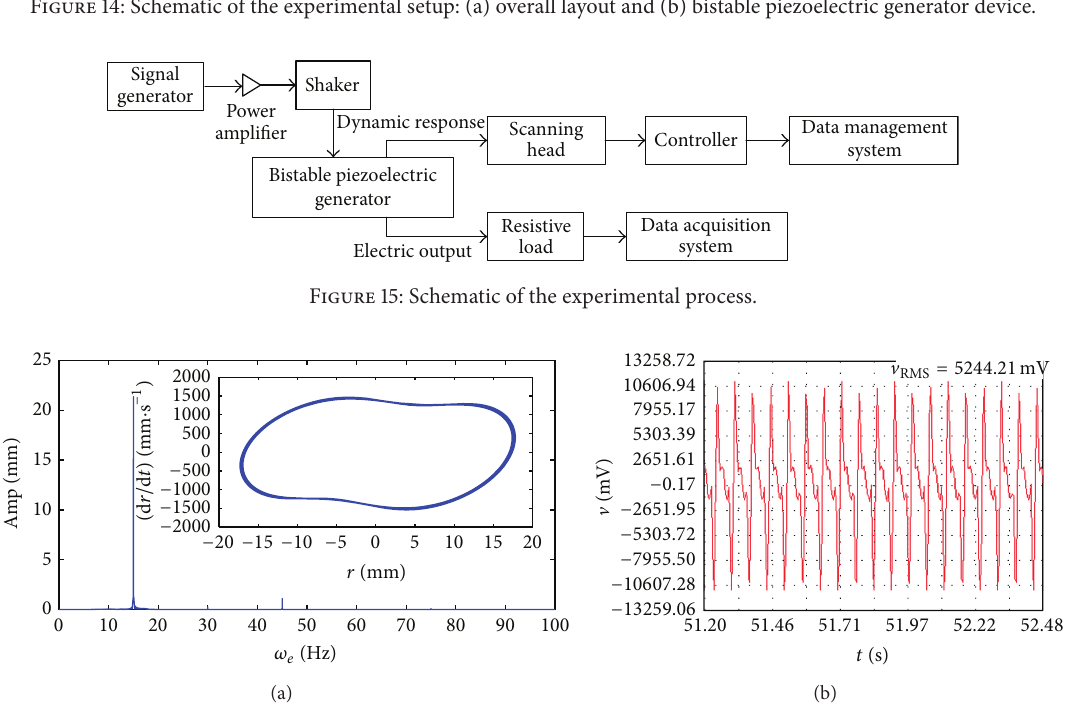
Figure 16: Experimentally obtained period-1 response for 𝑍 𝑒 = 2.5𝑔 and 𝜔 𝑒 = 15 Hz: (a) phase plot and frequency spectrum and (b) time series of output